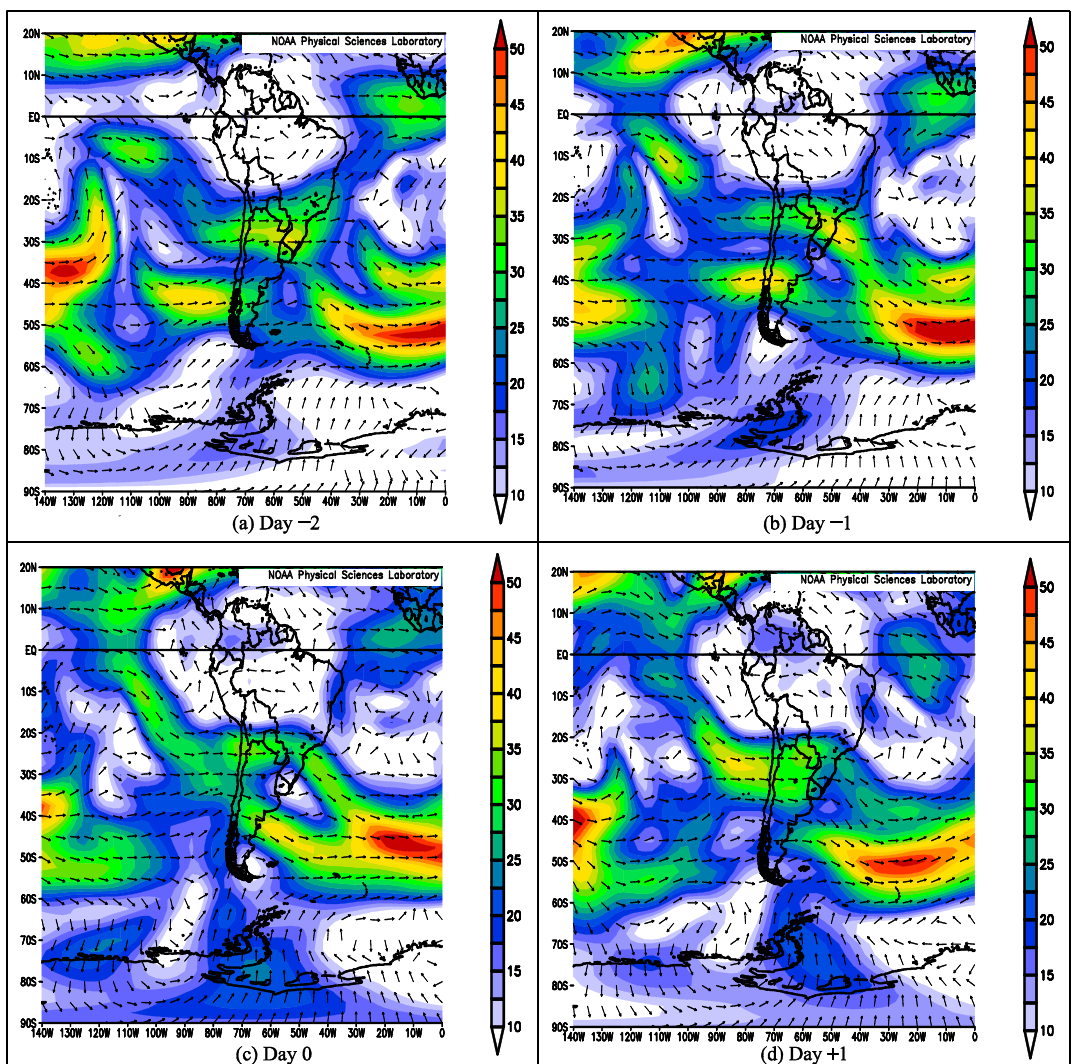
Figure 11. Wind composite mean (m/s) at high levels of the atmosphere (200 hPa) for ( a ) day − 2, ( b ) day − 1, ( c ) day 0, and ( d ) day +1 of the rainfall event on 15 January 1970. Source: NOAA/ESRL Physical Sciences Laboratory.